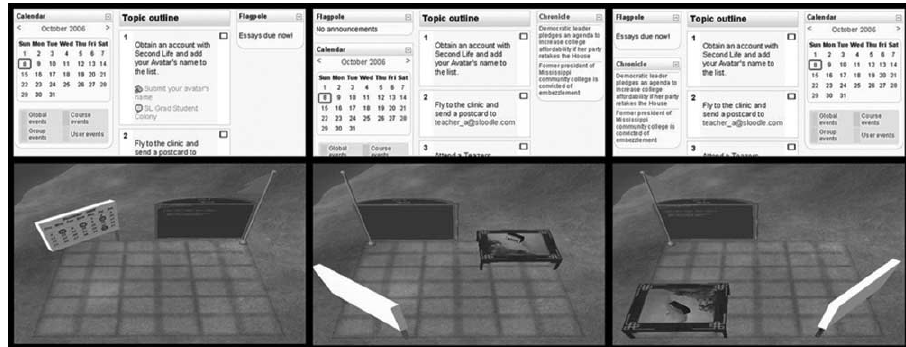
Figure 2. The Sloodle classroom – realising Moodle courses in